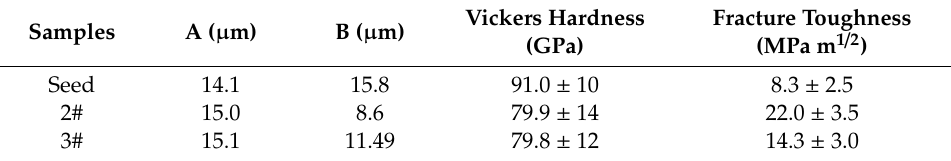
Table 2. Vickers hardness and fracture toughness of di ff erent